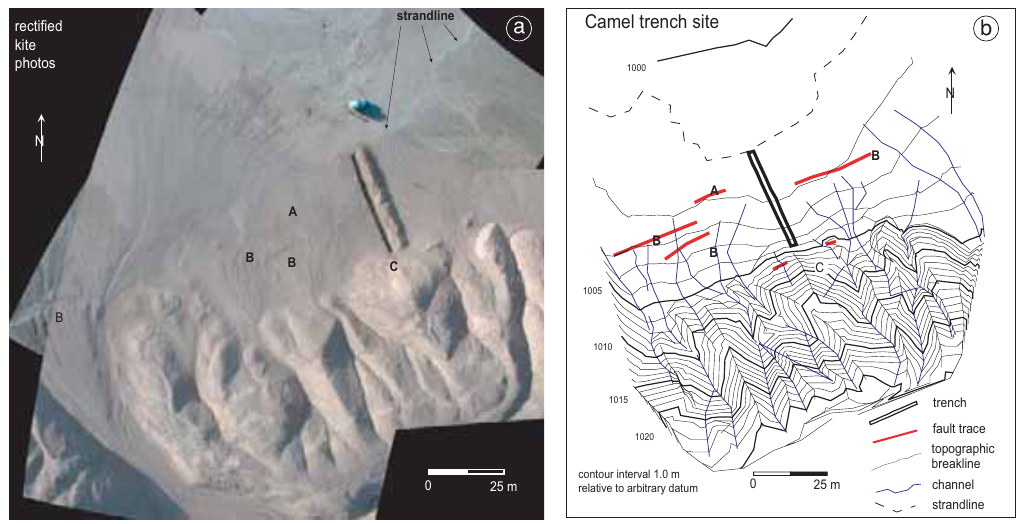
Fig. 5a,b. a) Rectified kite aerial photograph mosaic showing the geomorphic setting and geometry of surface rupture traces at the Camel trench site. Note the playa strandline at the north end of the trench, small dunes just south of the strandline on the east side of the trench, Neogene hills at the southern end of the trench, and allu- vial fans at the base of these hills. b) Topographic map quantifying the landforms at this site. The letters (A, B, C) on both figures identify corresponding fault traces discussed in the